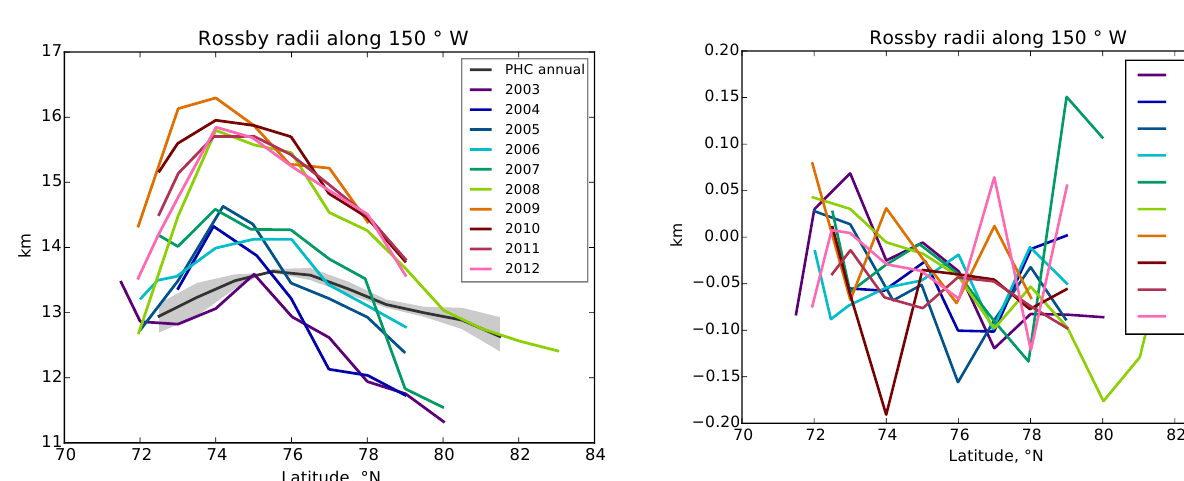
Figure 5. Difference between BGEP Rossby radii, decimated minus full